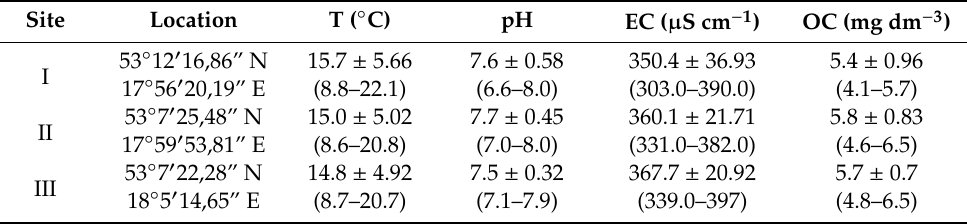
Table 1. Physico ‐ chemical parameters of water. Results are presented as means ± SD; range is given in brackets.